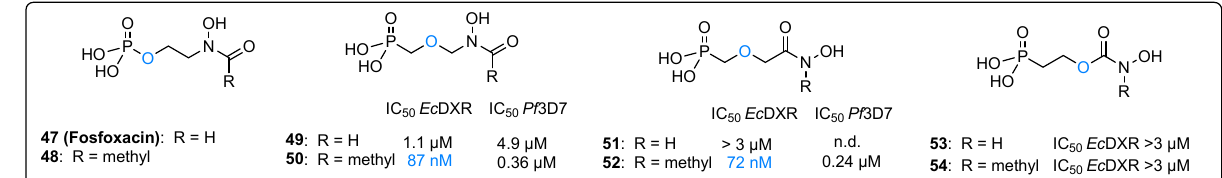
Figure 15. Structure and biological activity of the oxa analogs 47 – 54 .